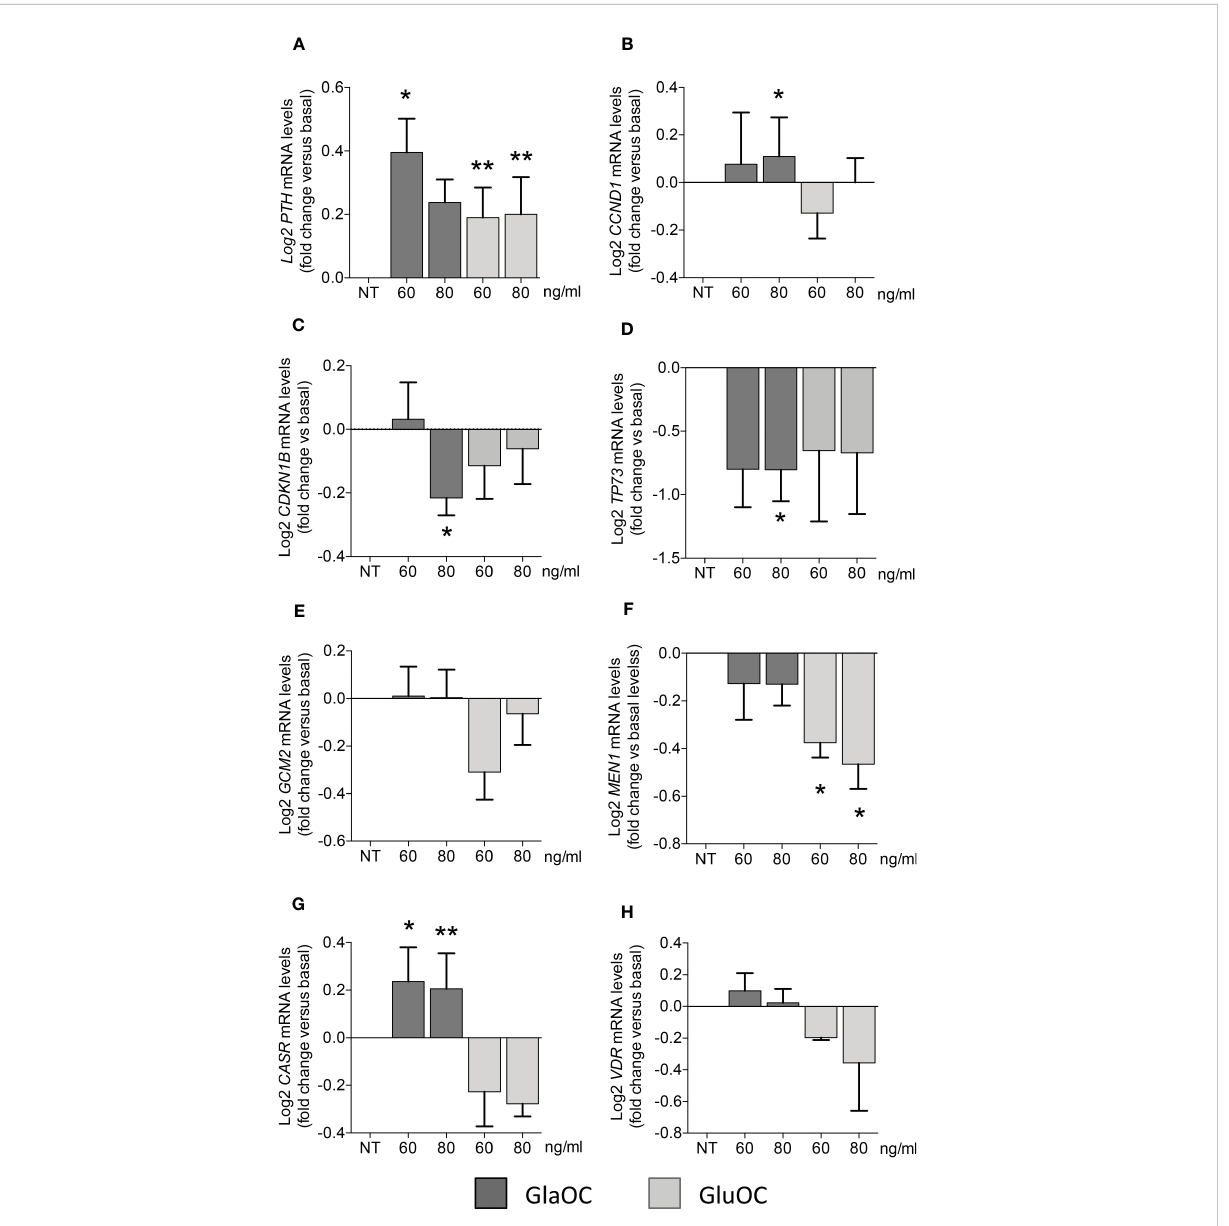
FIGURE 2 Effects of GlaOC and GluOC stimulation on the expression of speci fi c genes in PAds-derived cells. PAds-derived cells were incubated for 6 hours with increasing concentrations (60-80 ng/mL) of GlaOC (dark grey columns) and GluOC (light grey columns). Data were expressed as fold change versus levels in non treated conditions (NT) and presented as mean ± SEM. GlaOC and GluOC modulated the expression of (A) PTH mRNA levels (*, P=0.015; **, P=0.008), (B) CCND1 transcripts (*, P=0.002), (C) CDKN1B mRNA levels (*, P=0.041), and (D) TP73 mRNA levels (*, P=0.042). Effects of GlaOC and GluOC on parathyroid speci fi c transcription factors (E) GCM2 mRNA levels, (F) MEN1 mRNA levels (*, P=0.0001), and on (G) the receptors CASR (*, P=0.002; **, P=0.014) and (H) VDR mRNA levels are